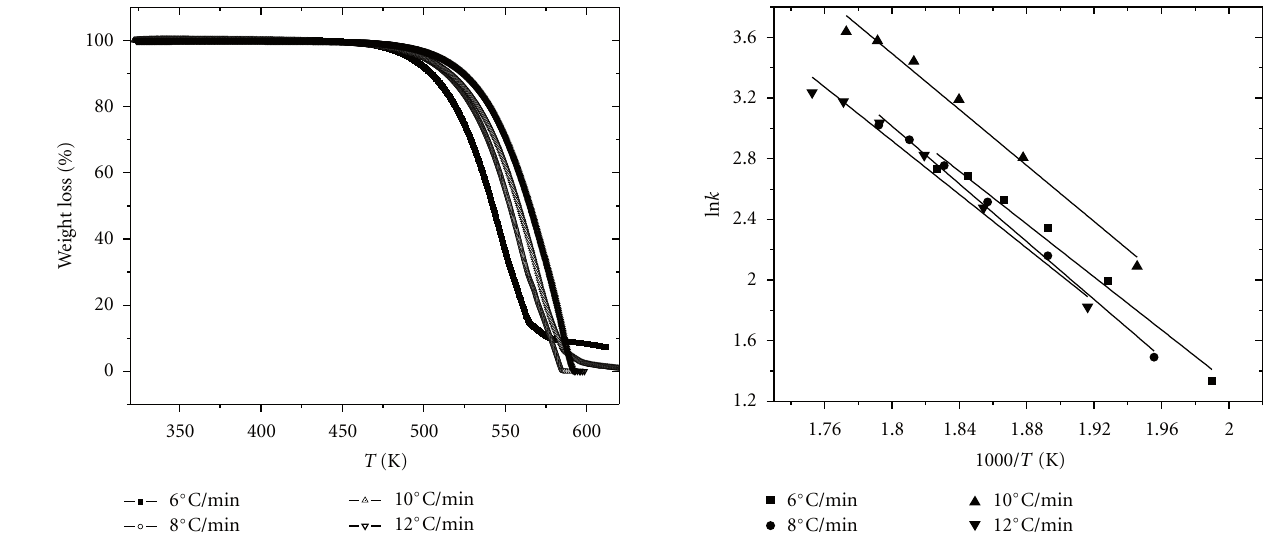
F 2: Arrhenius plots of Zr